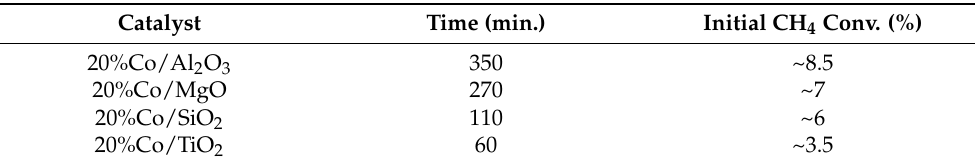
Table 12. Catalytic performance of cobalt catalysts prepared via conventional impregnation method with different supports and tested at 500 ◦ C and 1 atm [92].